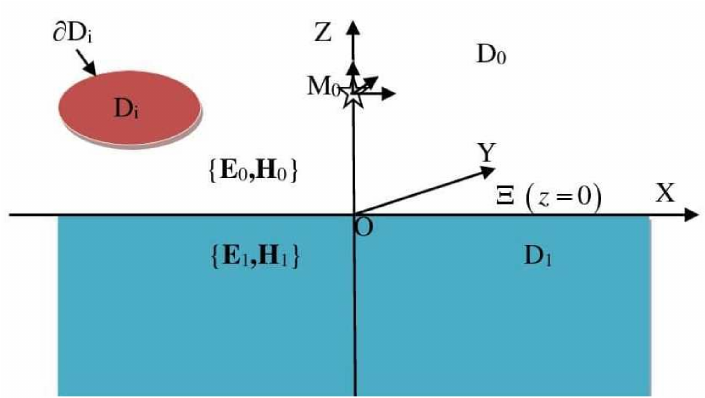
Figure 1. Scheme of the scattering